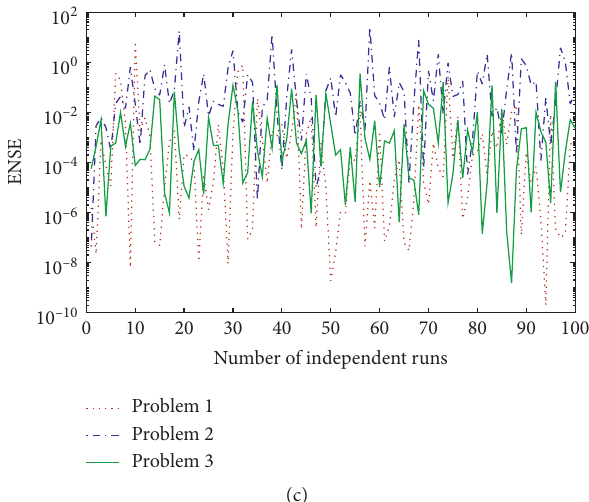
Figure 3: Convergence of performance indices during 100 independent runs for beam equations presented in Problems